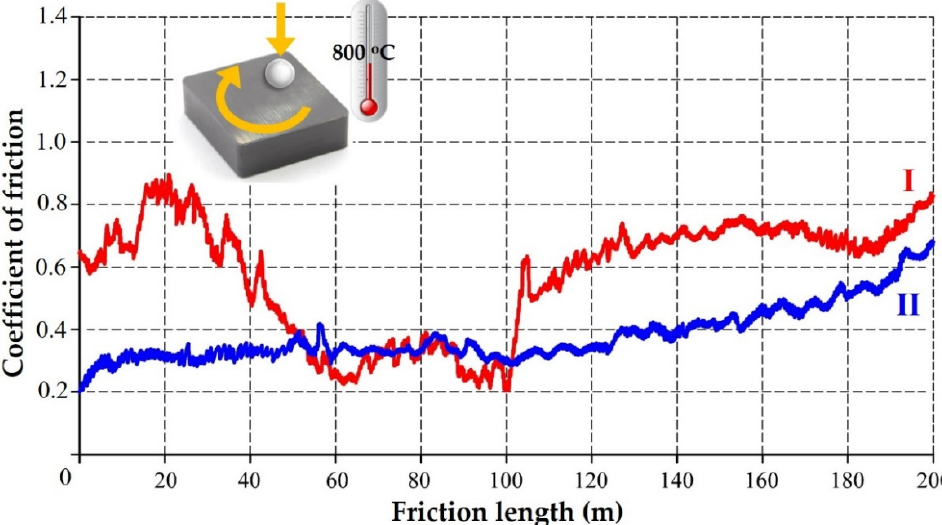
Figure 6. Dependences of the coefficient of friction during high-temperature heating of Al 2 O 3 +TiC ceramic inserts with the different conditions of the surface layer (I—diamond grinding; II—diamond grinding, lapping and polishing) on the length of the friction path.